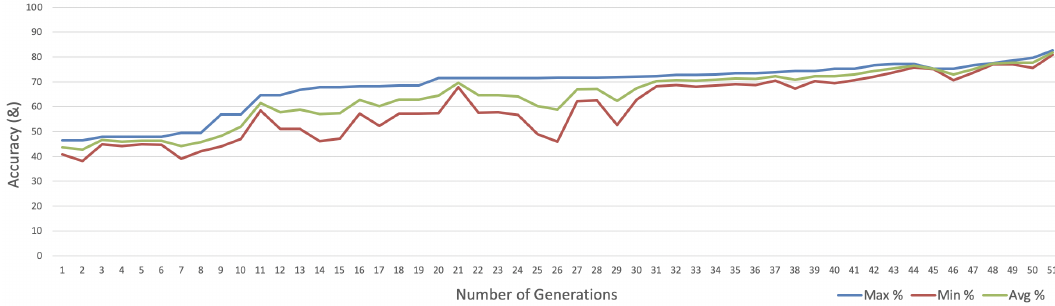
Figure 6. Graph showing the accuracy of networks against the number of generations.